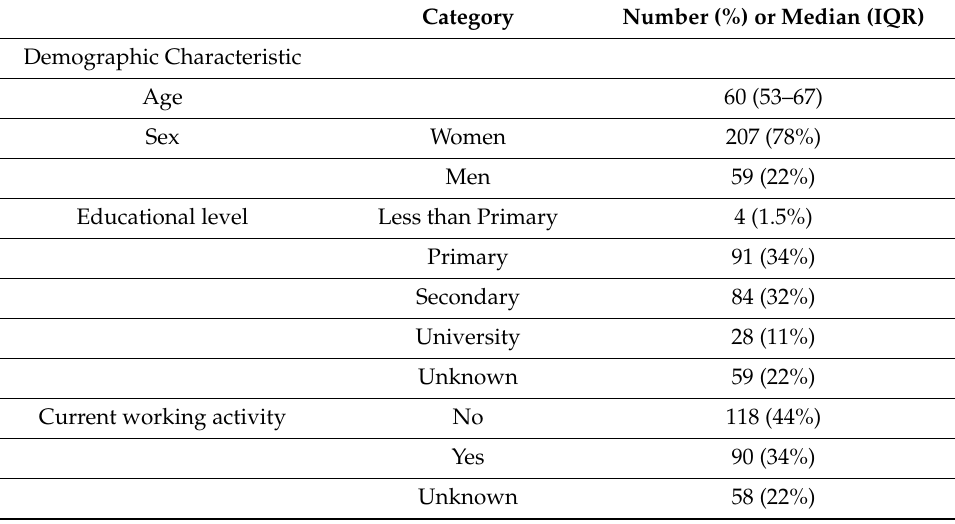
Table 1. Description of 266 patients with rheumatoid